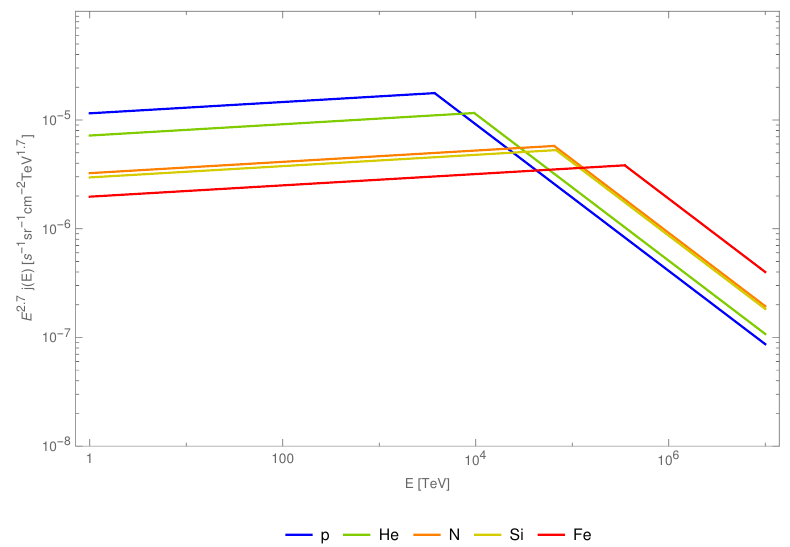
Figure 11. Parameterised differential energy spectrum for representatives of primary cosmic-ray nuclei used in this work.